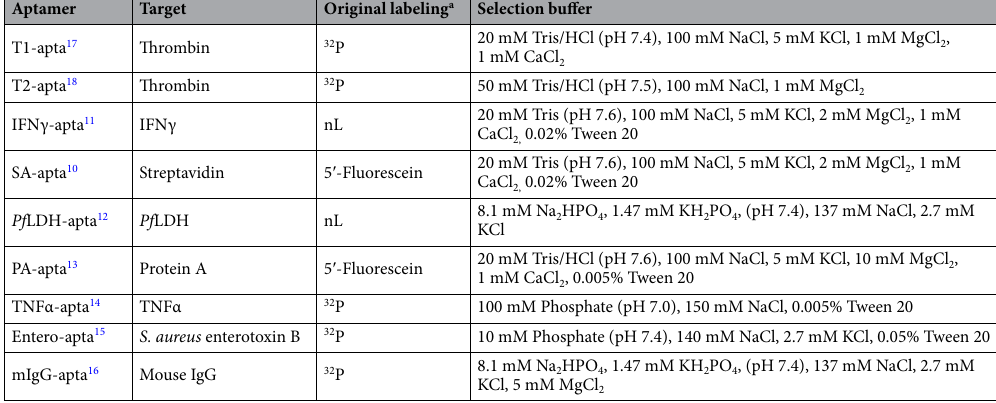
Table 1. Selection buffer composition of the used aptamers. nL not labelled. Aptamer sequences can be found in Supplementary Table S1. a We used all sequences labelled with Cy5 at the 5 ′